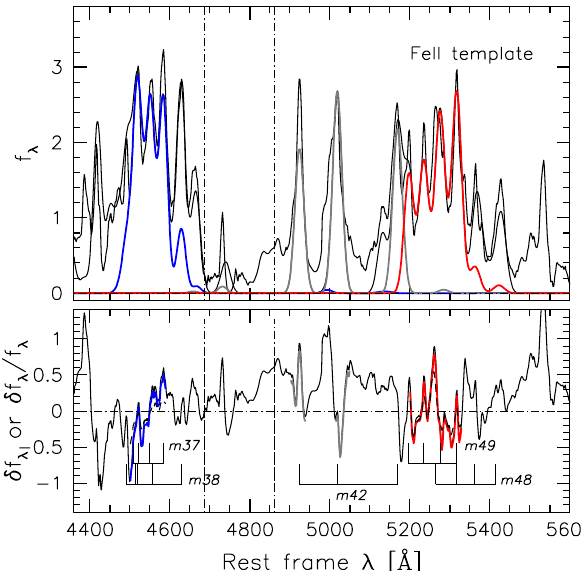
Figure 6. Non-linear χ 2 multi-component analysis of the adopted solid Fe II template with relative multiplet intensity free to vary. The blue solid line represents the B blends, while the red solid line indicates the R